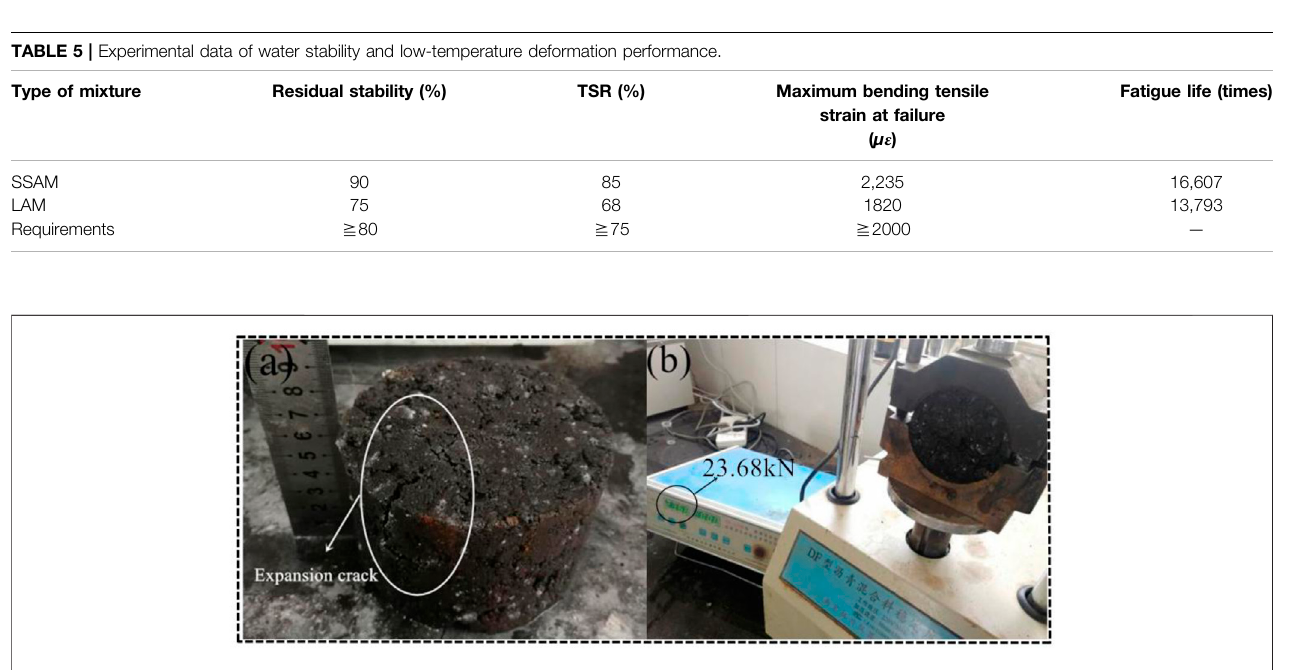
Frontiers in Materials |